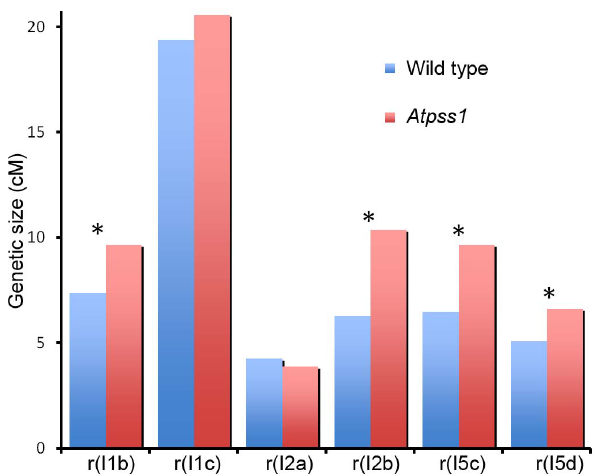
Figure 6. Genetic recombination in wild type and Atpss1-1 . Genetic distances in six intervals using tetrad analysis with fluorescent- tagged lines (FTL), were calculated with the Perkins equation [67] and are given in centiMorgans. I1b and I1c are adjacent intervals on chromosome 1 and so on for the other pairs of intervals as described in [46] (Table